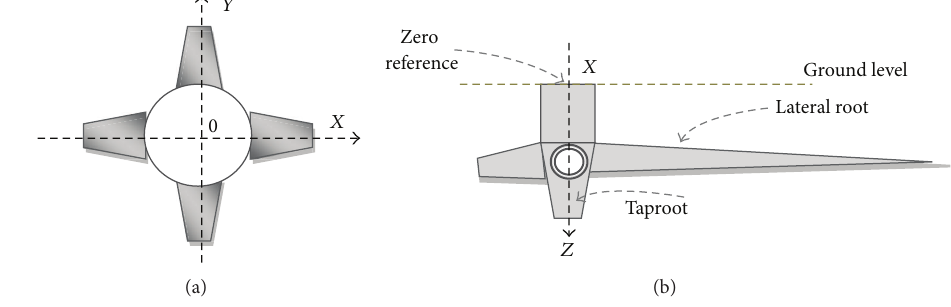
Figure 3: Coarse root structure. (a) Top view, (b) Lateral view.